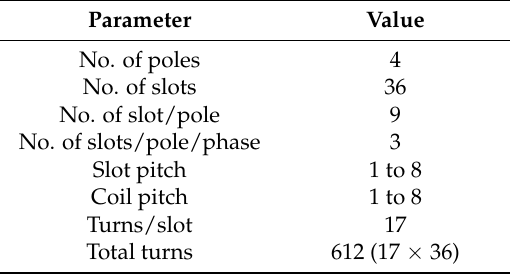
Table 2. Design values of the stator winding of the proposed multifunctional induction machine